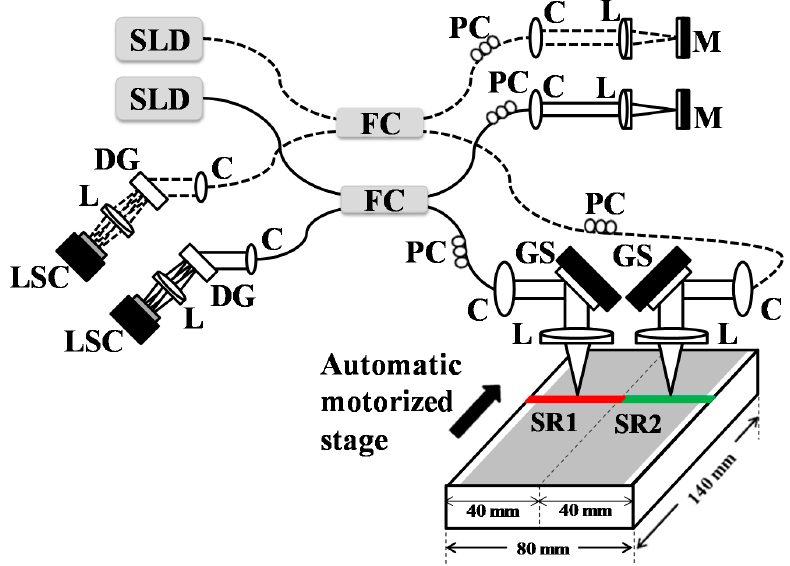
Figure 1. Optical architecture of two identical SD-OCT systems and sample stage. The red and green lines are respective scan ranges of two sample heads; Arrow indicates the direction of automatic motorized stage; C: collimator; DG: diffraction grating; FC: fiber coupler; GS: galvanometer scanner; L: achromatic lens; LSC: line scan camera; M: mirror; PC: polarization controller; SR1: scanning range 1; SR2: scanning range 2; SLD: super-luminescent diode.